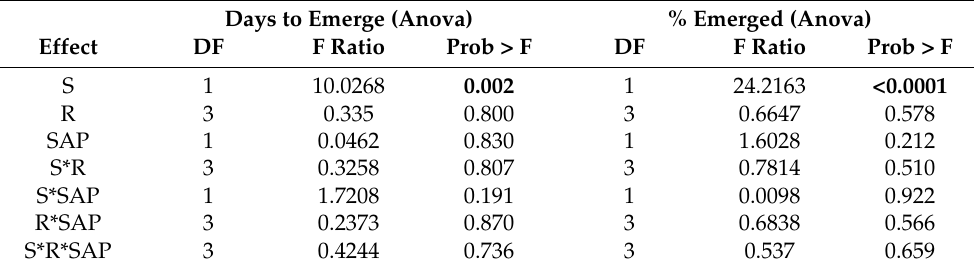
Table 6. Statistical results of a glass house study evaluating the effect of species (S), seeding rate (R), SAP rate (SAP), and their interactions on days to emergence and percent emergence. Bolded numbers indicate p < 0.05. Days to Emerge